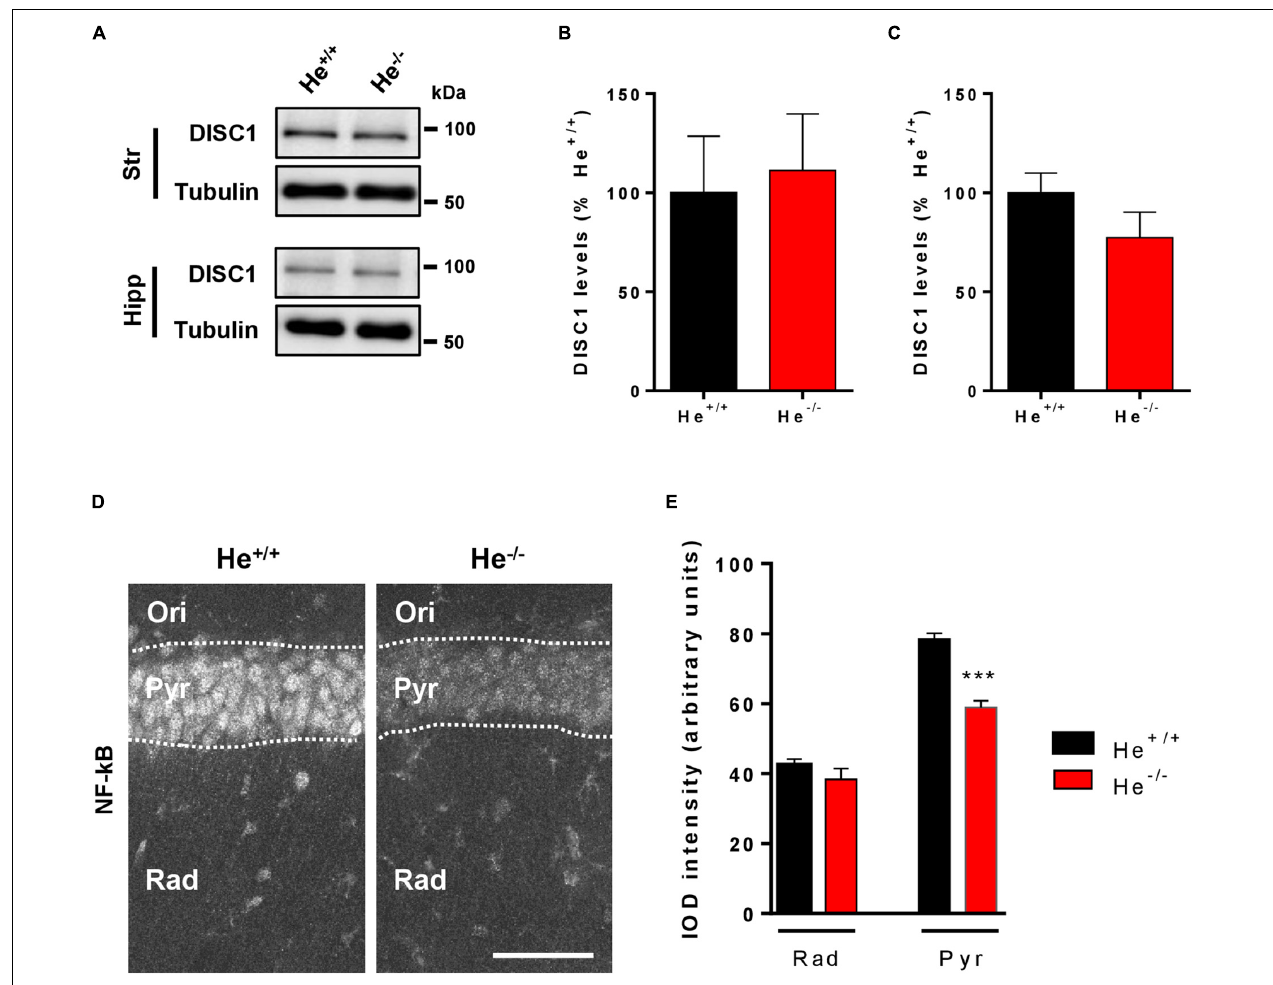
FIGURE 5 | Levels and distribution of DISC1 and NF- κ B in the hippocampus of He − / − mice. (A) Immunoblotting for DISC1 and Tubulin as a loading control in the striatum (Str, n = 9/genotype) or hippocampus (Hipp, n = 10–11/genotype) of 8-week-old He + / + and He − / − mice. Densitometry quantification in the striatal (B) and hippocampal (C) samples of results as in (A) . Data were normalized to tubulin for each sample and expressed as percentage of wild type. (D) Representative confocal images of NF- κ B immunofluorescence in CA1 (40x objective) of 8-week-old He + / + and He − / − mice ( n = 10 He + / + and 8 He − / − ). Scale bar = 70 microns. (E) Quantification of NF- κ B the IOD per layer (total IOD mean per layer). Bars represent mean ± SEM. Data were analyzed by Student’s t -test. *** p < 0.001 when compared with He + / + mice in (E)